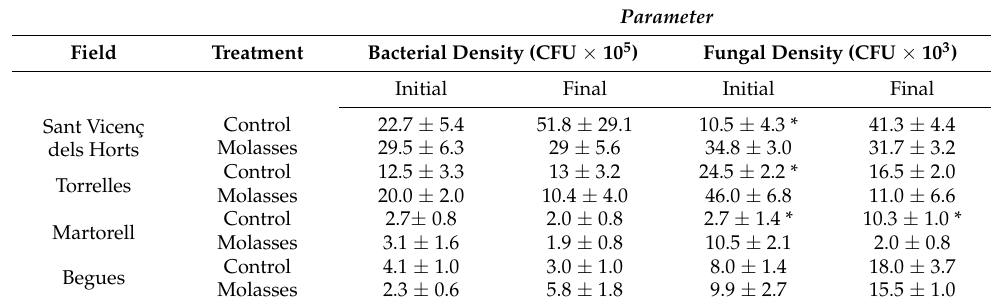
Table 4. Effect of 1 mL m − 2 of molasses application just after crop transplantation and 15 and 45 days later on soil bacterial and fungal densities (CFU) at the beginning and at the end of the lettuce cv. Paraday crop in four organic vegetable production